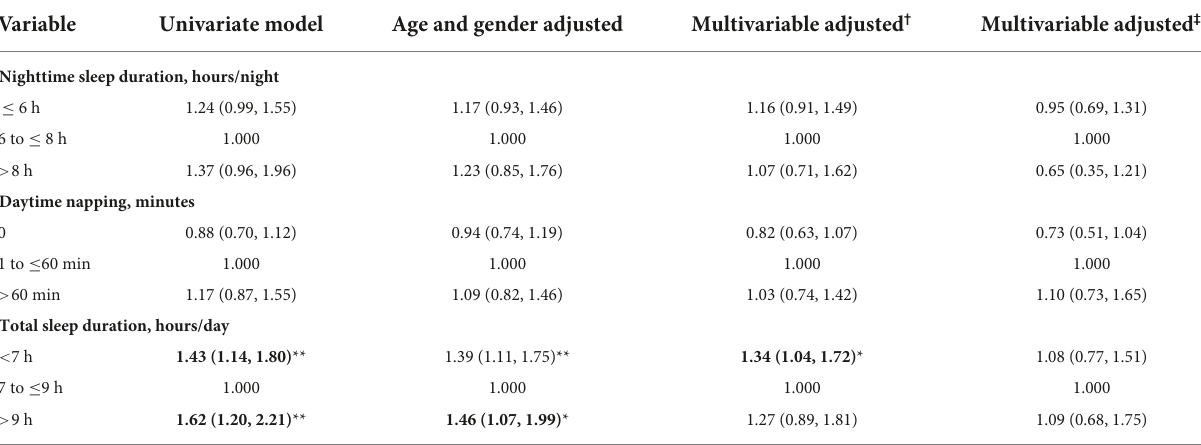
Total stroke, adjusted OR (95%CI)